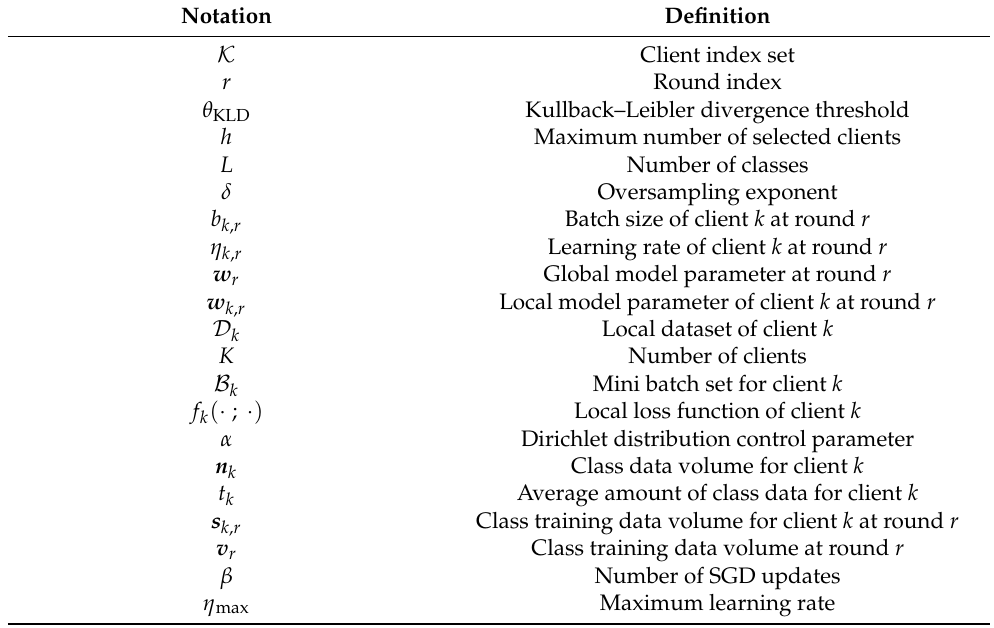
Table 1. Notation and